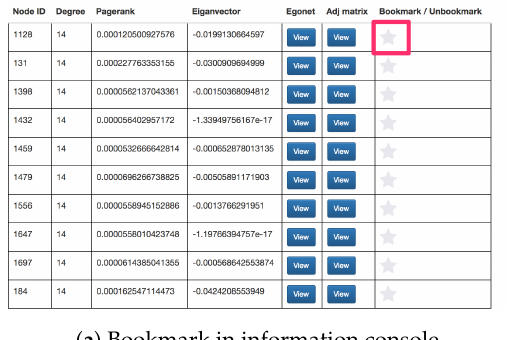
Figure 10. Illustration of the bookmark functionality.